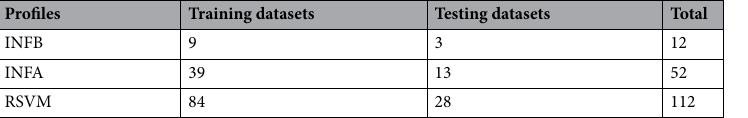
Table 1. Profile creation by HMM. INFA anti-Influenza A virus, INFB anti-Influenza B virus; RSVM anti- respiratory syncytial